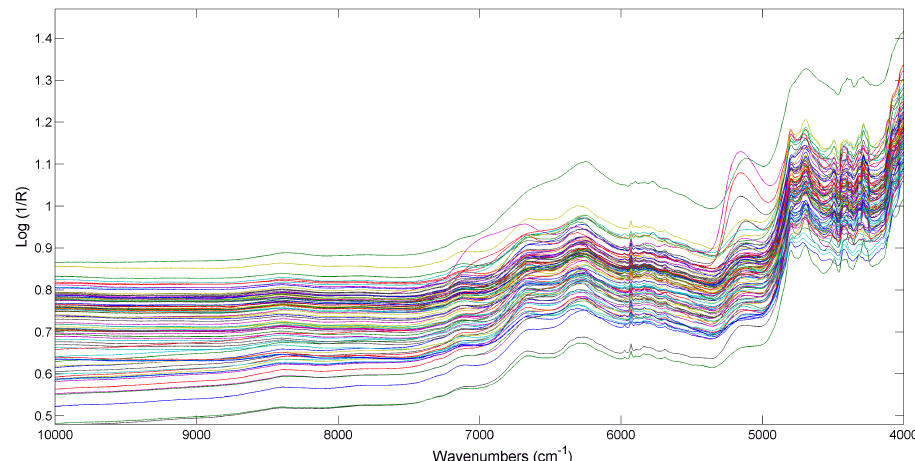
Fig. 1. Raw spectra of 88